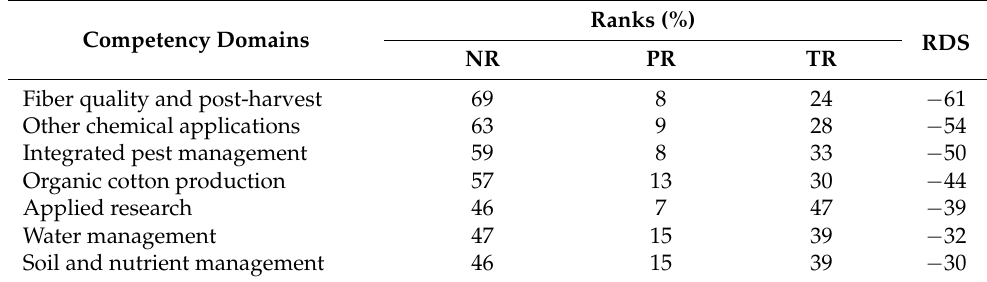
Table 1. Mean Ranked Discrepancy Scores for competency areas in sustainable cotton